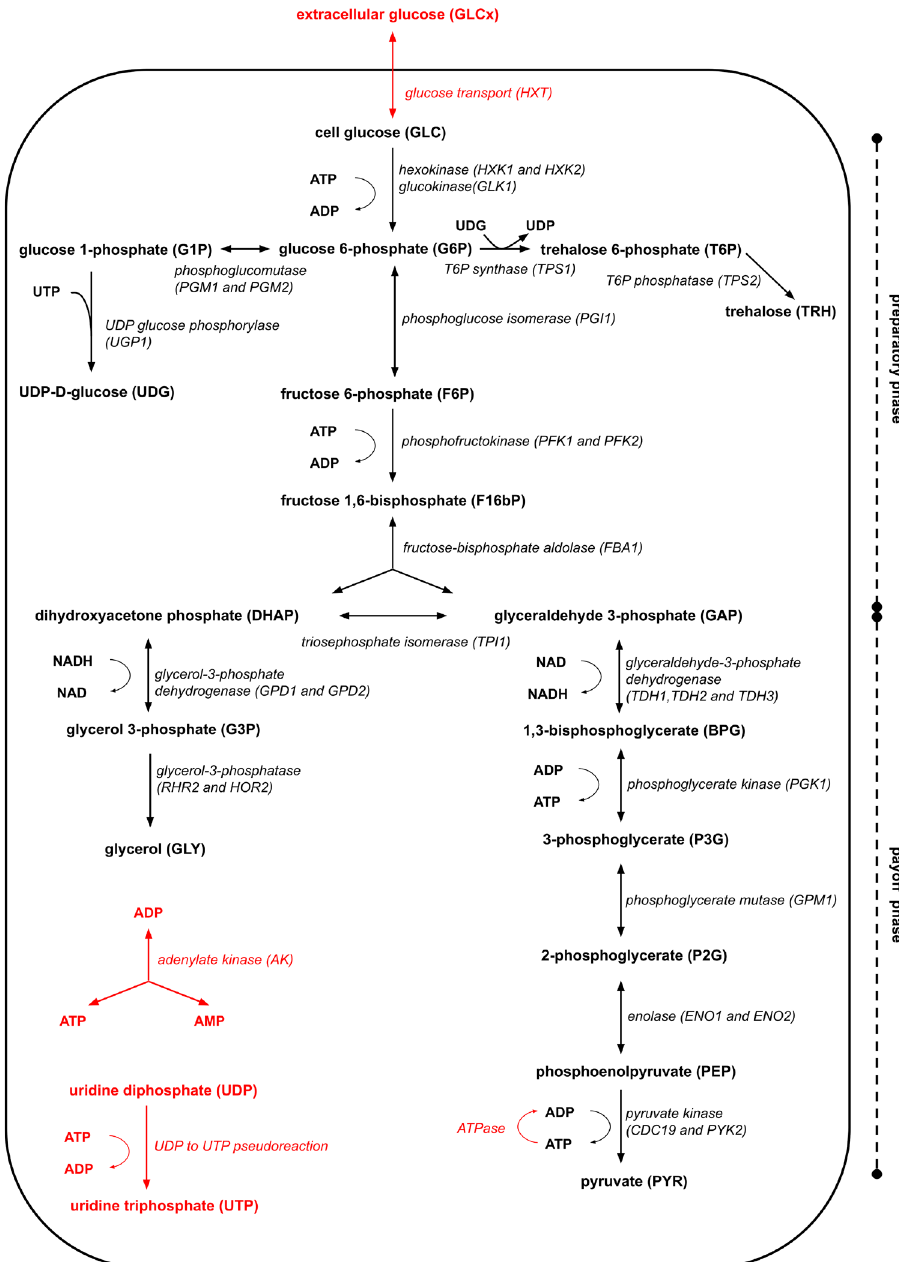
kinetic model 16 . The reactions in red are those excluded during the conversion; see the “Methods” section of this manuscript and Sect. 2 of the Supplementary Information for details on the conversion process from the SBML source to our ABM. For each metabolite involved, we report both the name and the acronym (in bold), while, for every reaction, we indicate the abbreviation of each isoenzyme carrying it out (in italics). On the right side of the image, we highlight the two main phases of the process; since the ethanol fermentation has not been simulated, we prefer not to show this phase to preserve the readability of the